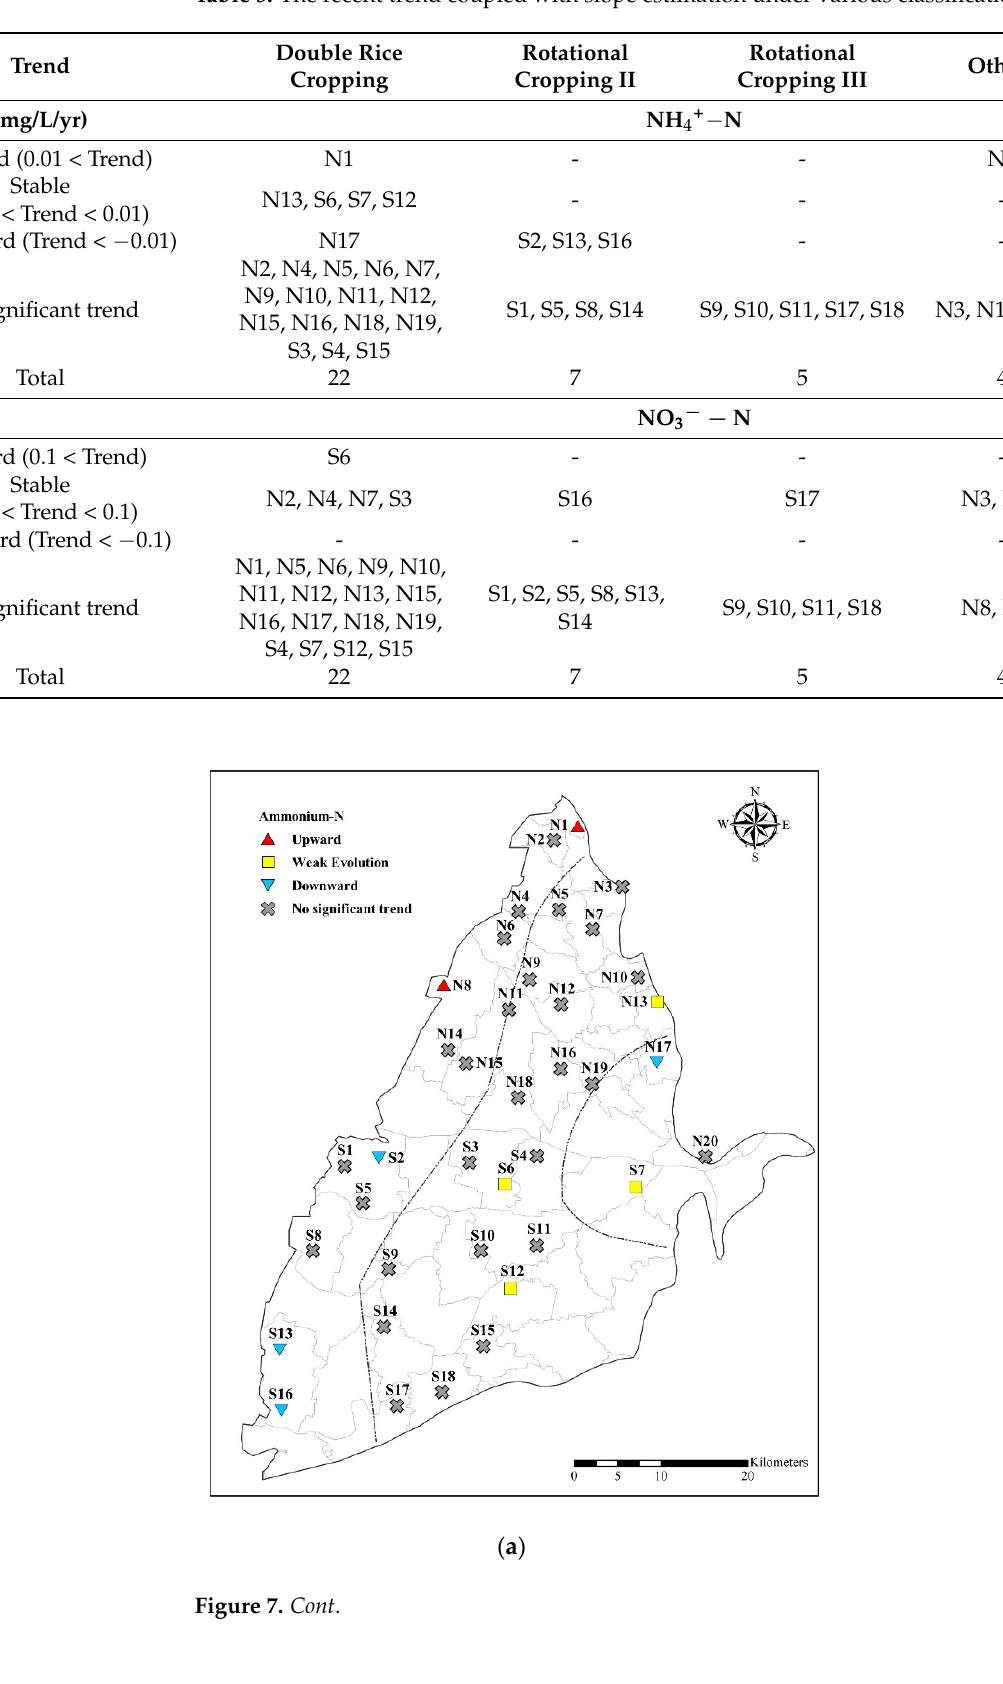
Table 5. The recent trend coupled with slope estimation under various